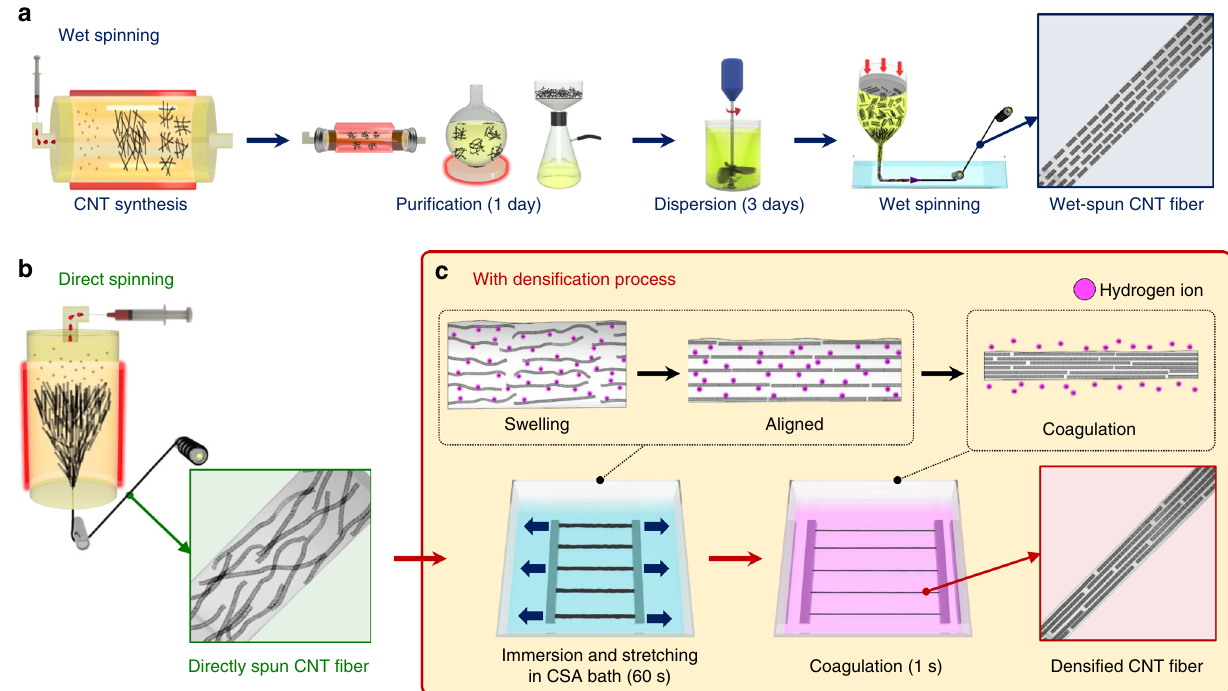
Fig. 1 Schematic representation of spinning methods for CNTFs. a Wet spinning, b direct spinning, and c fast densi fi cation process based on the principles of the wet spinning method, which can be attached to the end of the direct spinning process